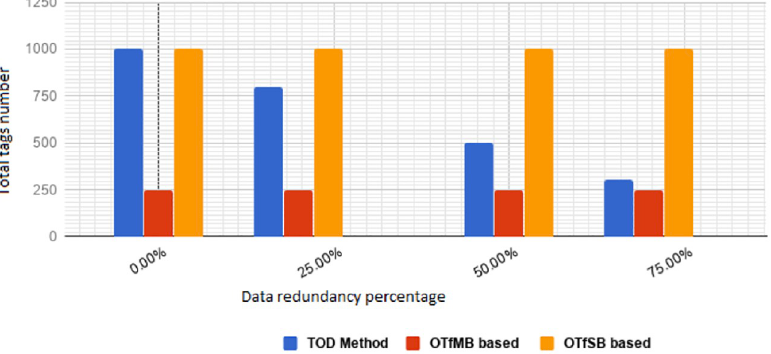
Fig 12. TOD method vs the OTfMB and OTfSB approaches: The number of tags generated against data redundancy percentage, K = 1000, total number of blocks in a data file, 4 Data Blocks are used in generating one tag in OTfMB approach.